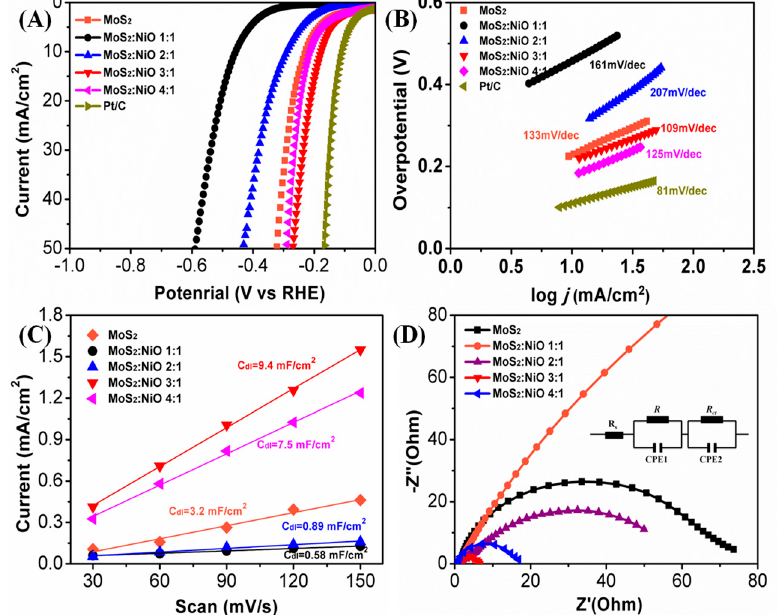
Figure 4. HER electrocatalytic activity of NiO/MoS 2 catalysts: ( A ) polarization curves after iR compensation; ( B ) Tafel plots of electrodes at a scan rate of 5 mV/s; ( C ) capacitive current at 0.165 V as a function of the scan rate; ( D ) EIS curves of electrodes at an overpotential of 200 mV.